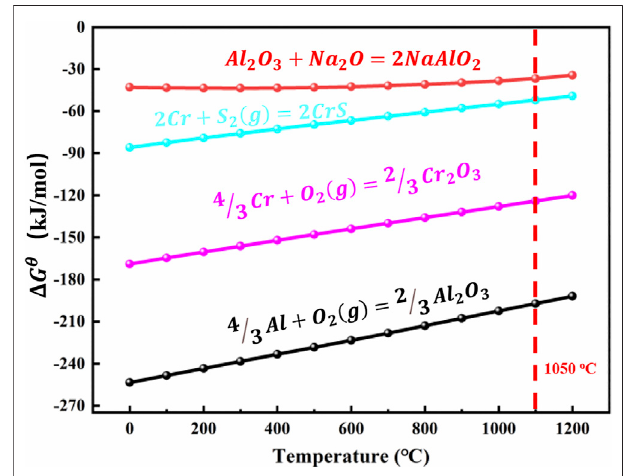
FIGURE 11 | Standard Gibbs free energy changes ( Δ G θ ) of forming compounds as a function of temperature.